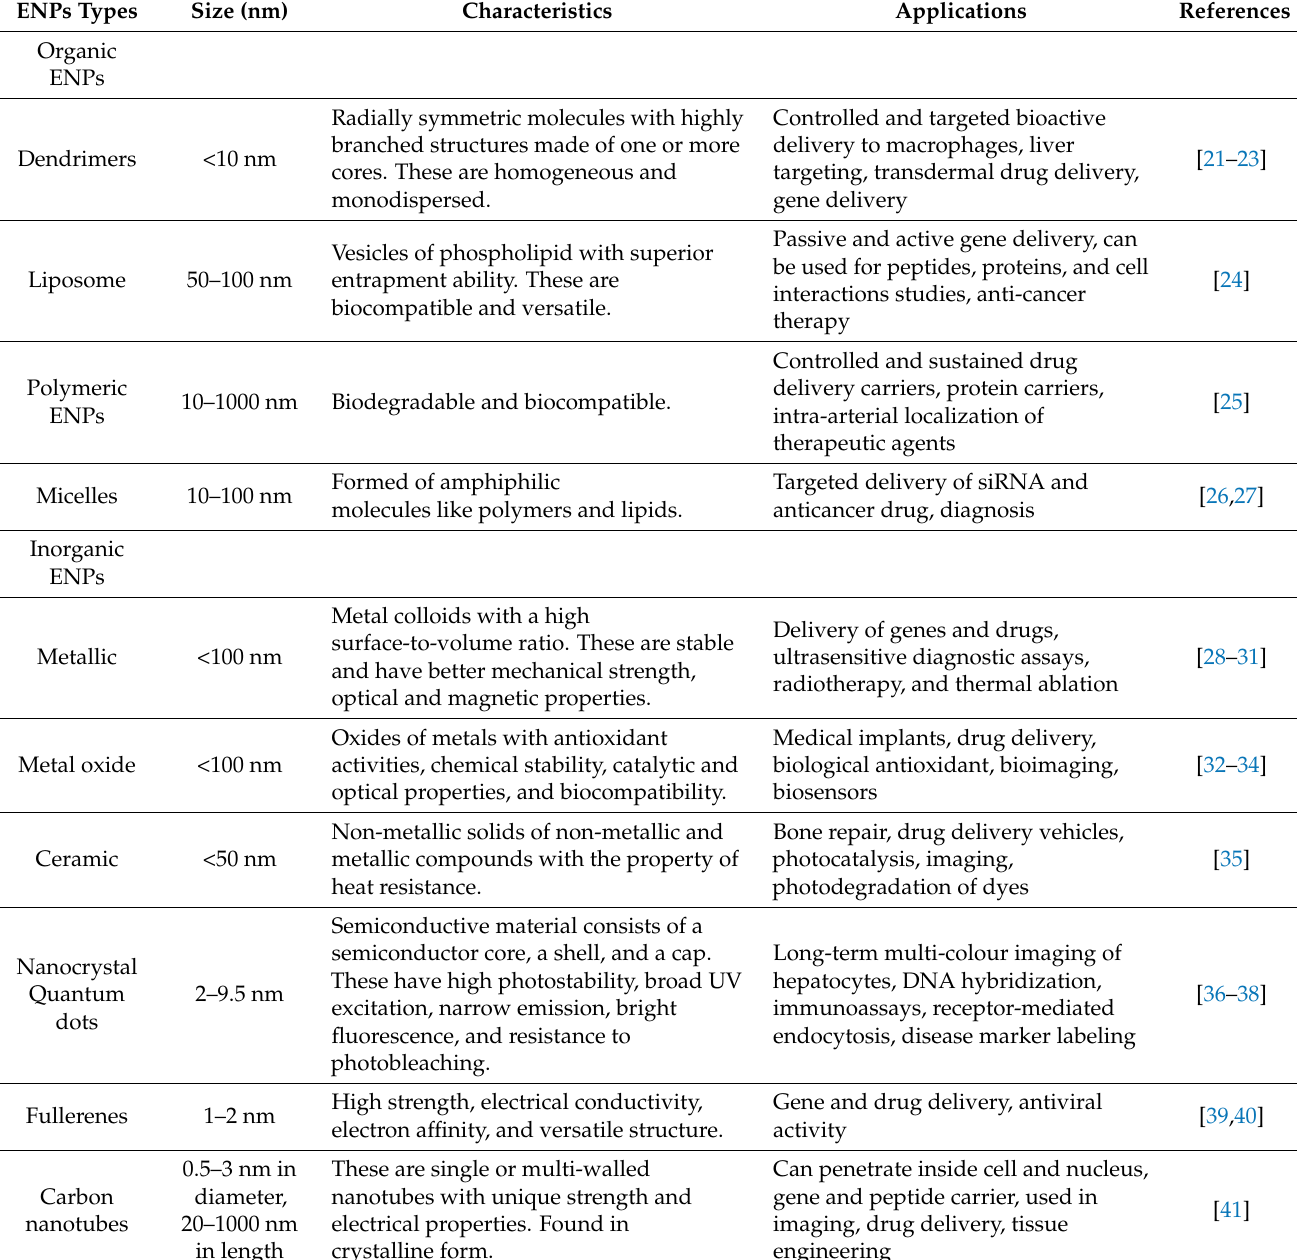
Table 2. Types of ENPs, their characteristics, and